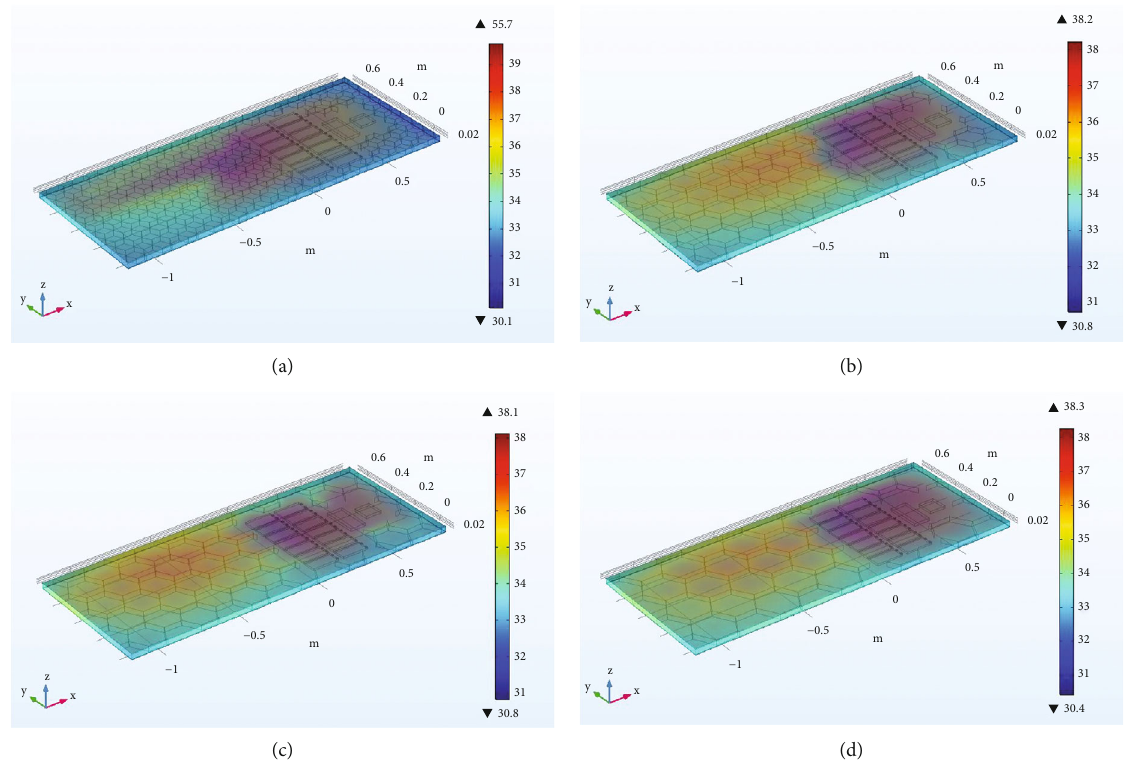
Figure 10: Temperature contours of H – PBIS under air convection condition: (a) 15000 s, (b) 25000s, (c) 35000 s, and (d) 45000s.